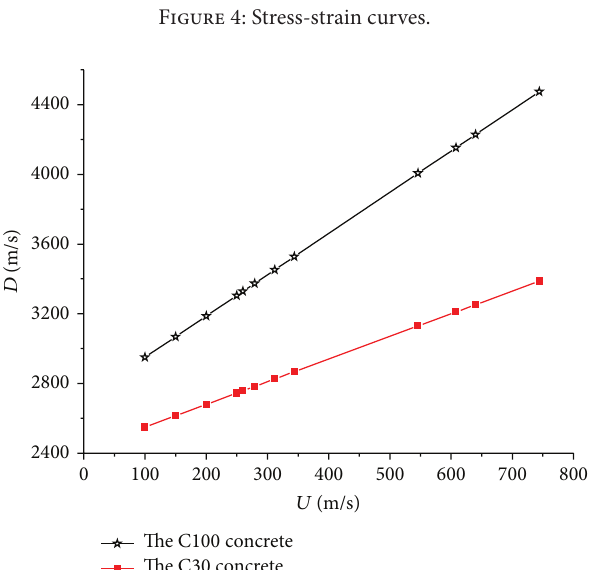
Figure 6: 𝑃 - 𝑈 curves of